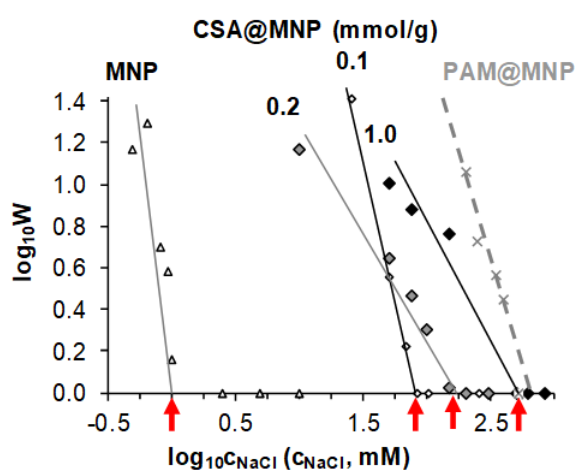
Figure 6. Stability plot to determine the values of the critical coagulation concentration (marked with red arrows) of MNPs in the absence of CSA coating (open triangle symbols) and in the presence of 0.1, 0.2, and 1.0 mmol/g CSA (diamond symbols), measured at pH ~6.3. The previous results of PAM-coated MNPS with 1.2 mmol COOH/g MNP loading [19] (dashed line) are recalled here for comparison.